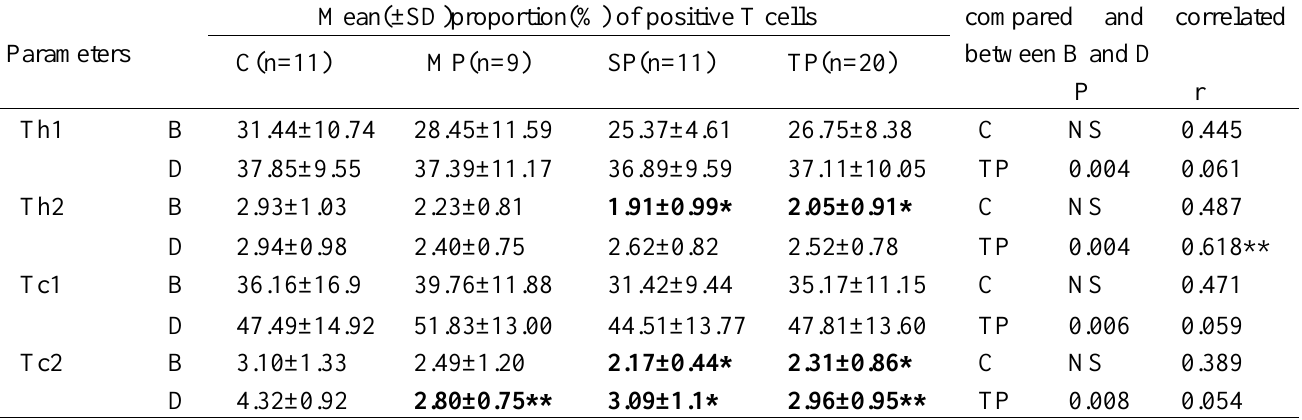
Table 4. Percentages of Th1, Th2, Tc1, Tc2 and ratios of Th1/ Th2, Tc1/ Tc2 in preecalmpsia patients and the